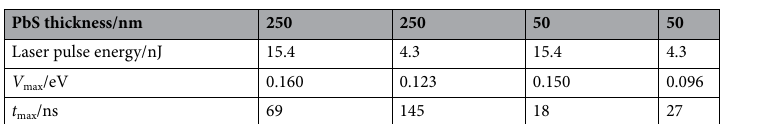
Table 1. Maximum photovoltage ( V max ) and delay time at which the maximum photovoltage was observed ( t max ) of kinetic traces obtained for the 250 nm and the 50 nm thick PbS samples at laser pulse energies of 15.4 and 4.3 nJ.